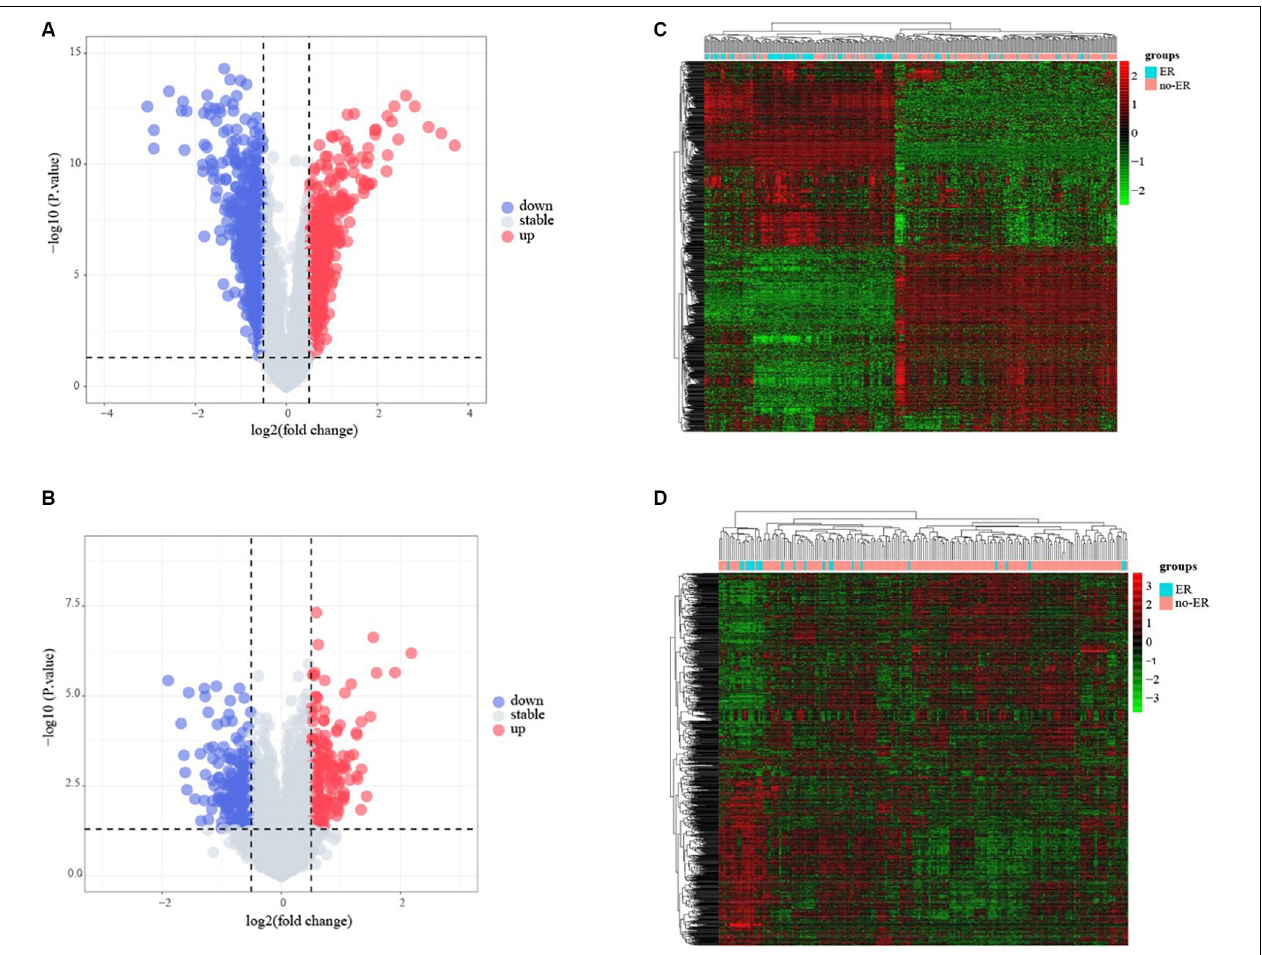
FIGURE 2 | Identification of early recurrence-associated DEGs in pediatric B-cell acute lymphoblastic leukemia. Volcano plot of DEGs from Total Set (A) and GSE13576 (B) . Genes with p < 0.05 and | log2(FC)| > 0.5 are shown in red (upregulated genes) and green (downregulated genes). (C,D) Heatmap of DEGs for two datasets, ER means early relapse, no-ER means no early relapse.